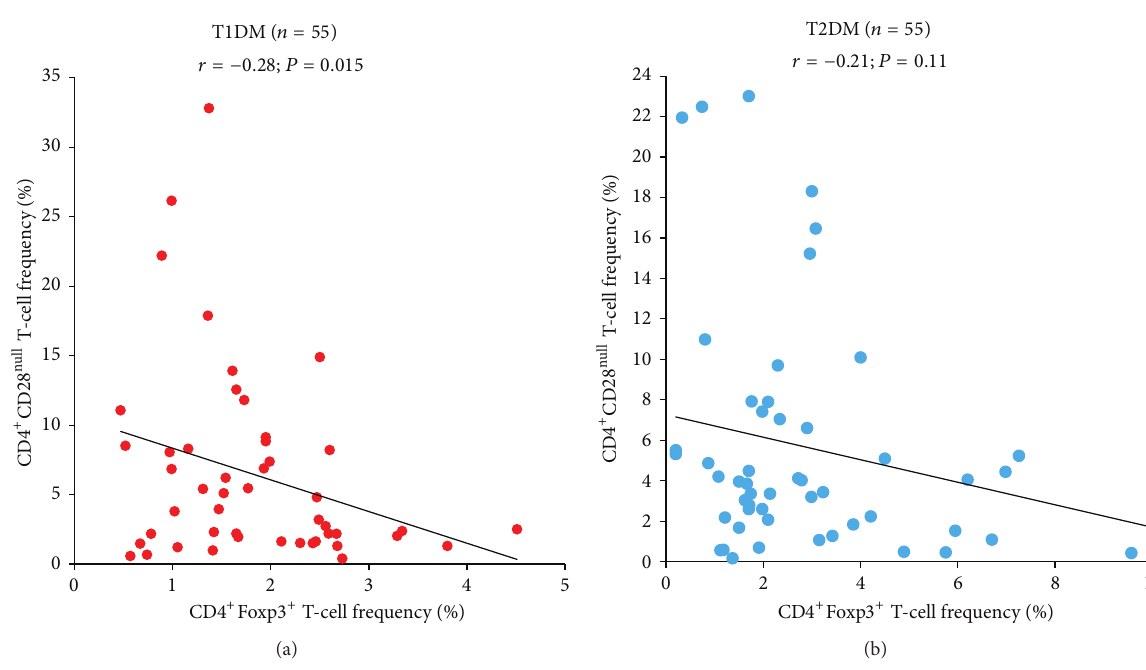
Figure 2: Correlation between CD4 + CD28 null T-cell and CD4 + FoxP3 + T-cell frequencies in T1DM and T2DM patients. Data are presented as single data points. (a) In T1DM patients, a significant negative correlation was found between CD4 + CD28 null T-cell and CD4 + FoxP3 + T-cell frequencies. (b) In T2DM patients, no correlation was found between CD4 + CD28 null T-cell and CD4 + FoxP3 + T-cell